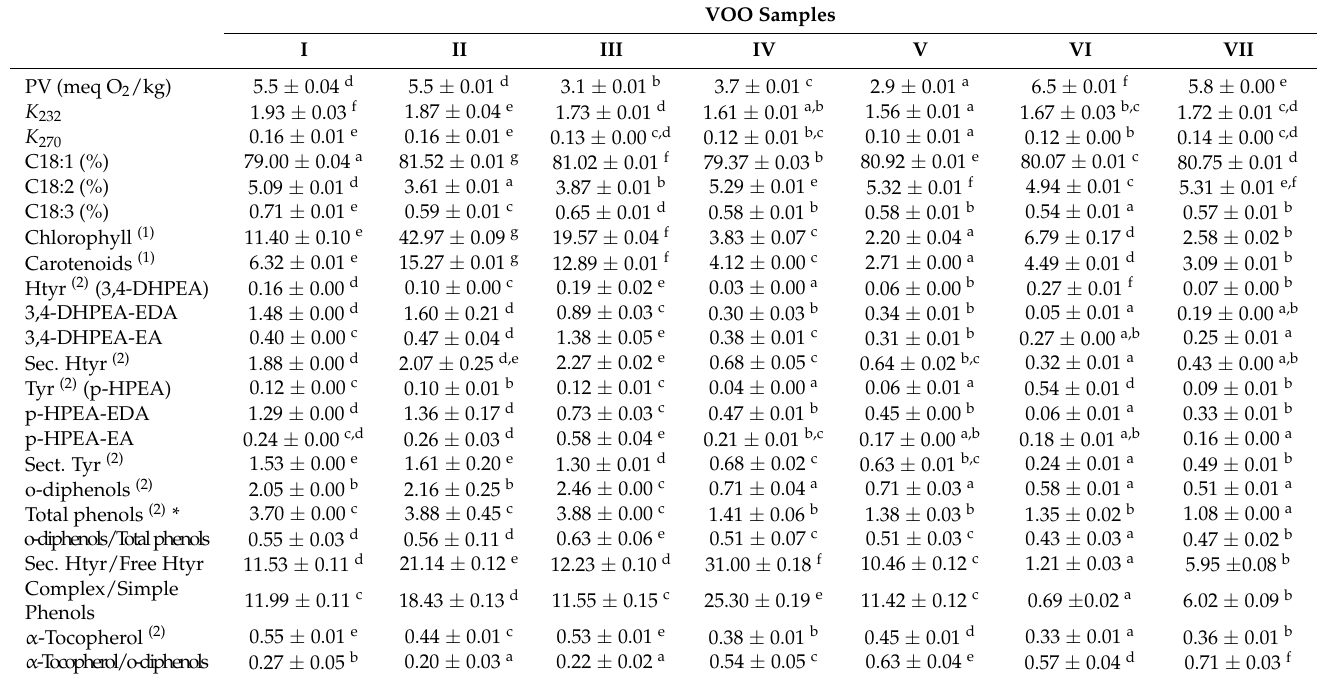
Table 1. Initial Composition and Quality Indexes of Olive Oil